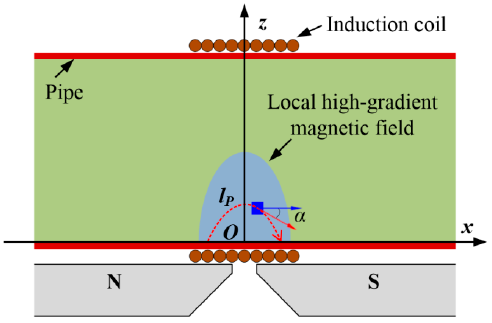
Figure 2. Working principle of sensor.